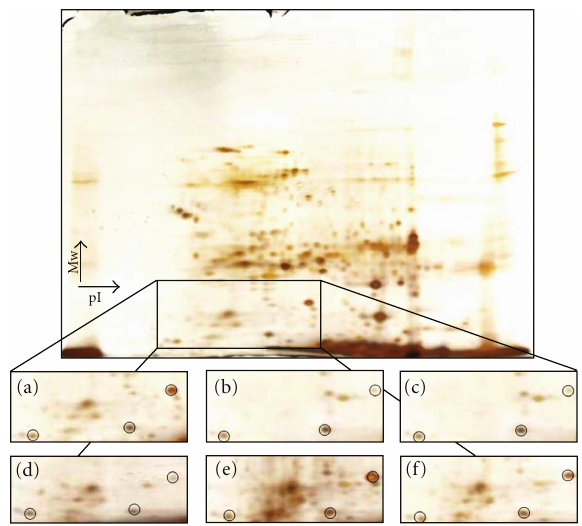
Figure 3: Two-dimensional separation of precipitated proteins (100 μ g) in PE placenta solubilized in urea/CHAPS. Segments show di ff erential expression pattern in consequence of precipitation procedures. (a) dichloromethane/methanol, (b) TCA, (c) TCA followed by ethanol wash, (d) acetone, (e) acidified acetone, and (f) ethanol. Circles indicate landmarks for orientation. The gels were stained with